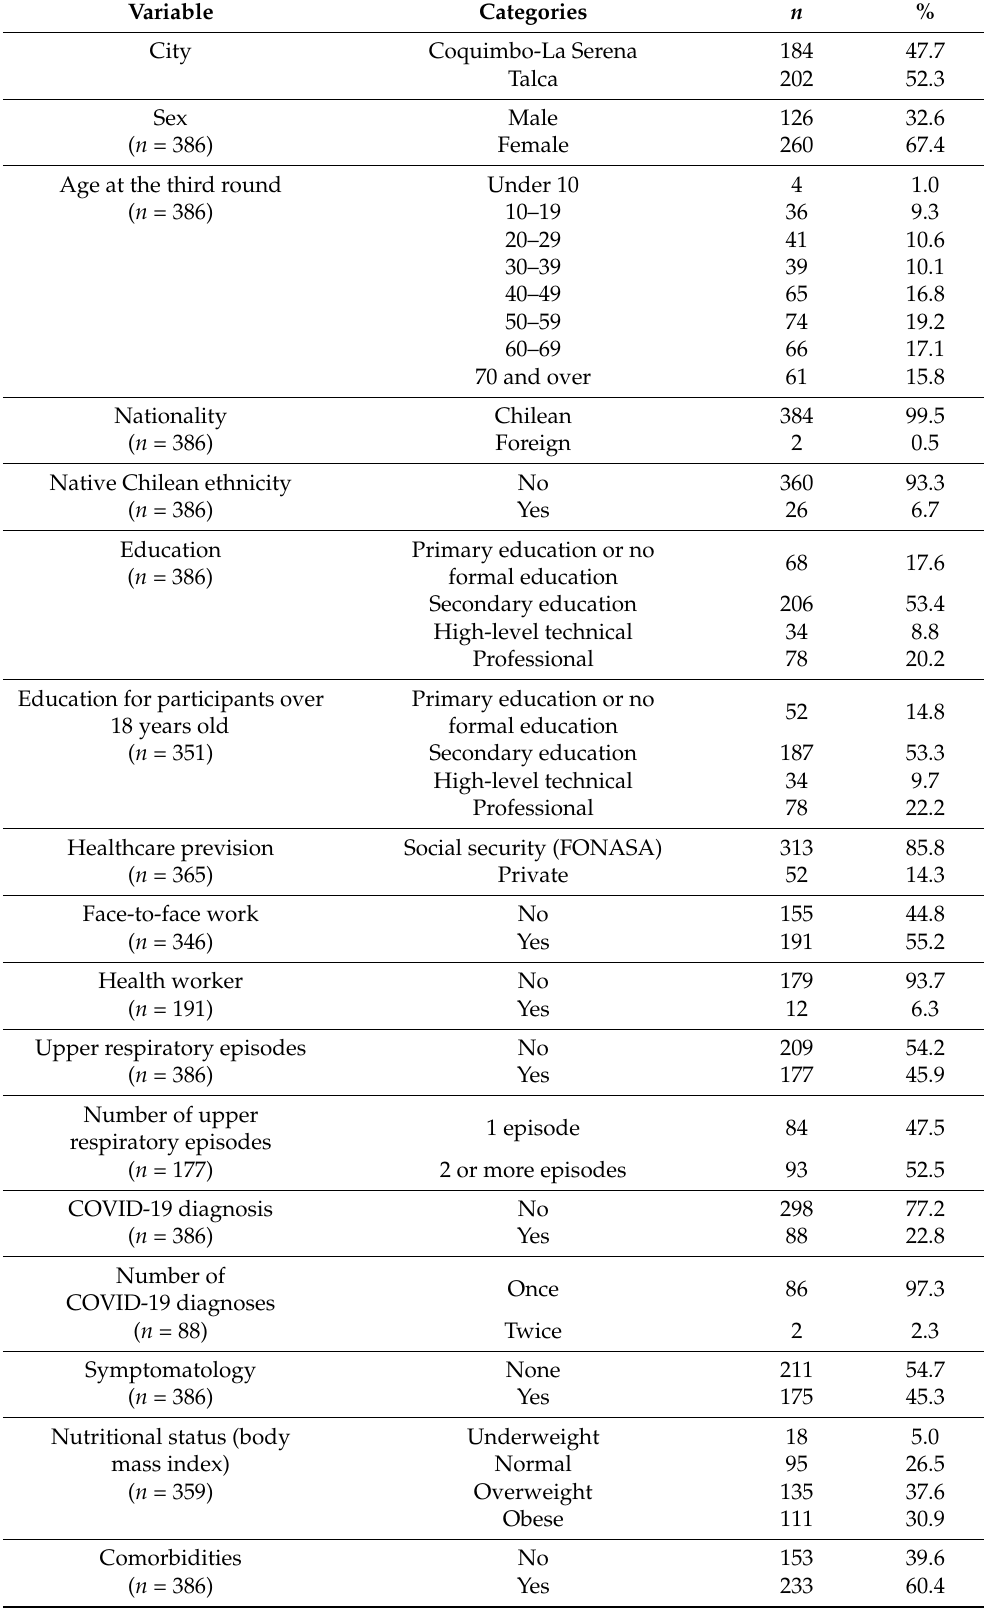
Table 1. Description of the characteristics of the participants in the three rounds of the seroprevalence study in two Chilean cities,